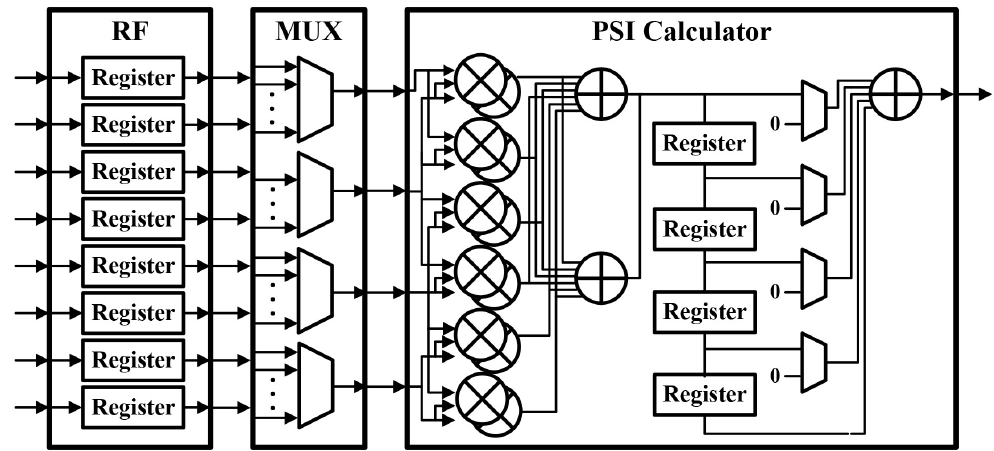
Figure 9. Hardware architecture of least square module (LSM).